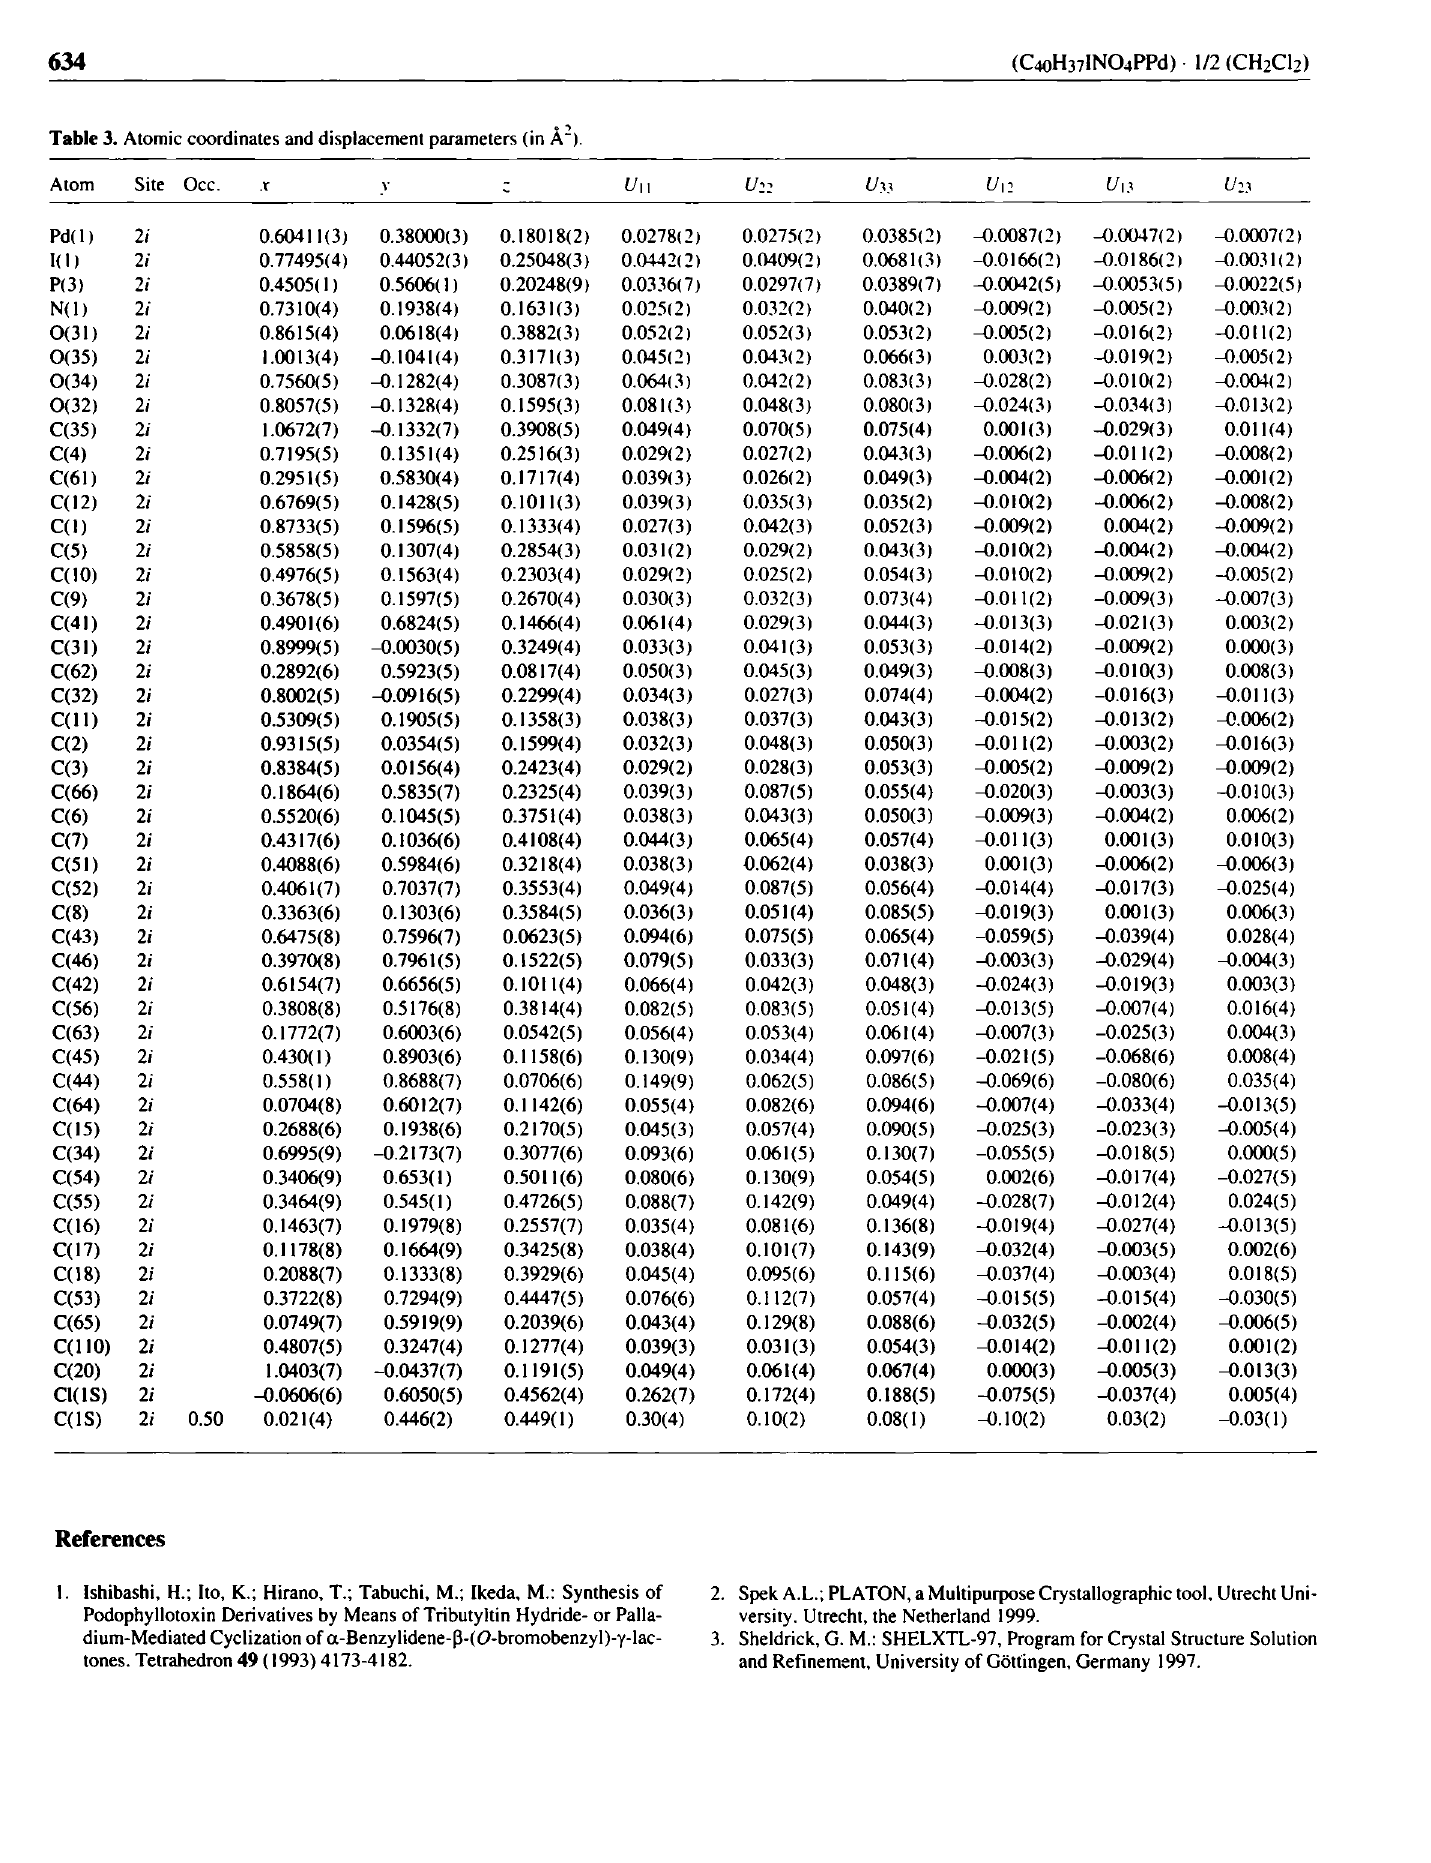
Table 3. Atomic coordinates and displacement parameters (in A 2 ). Atom Site